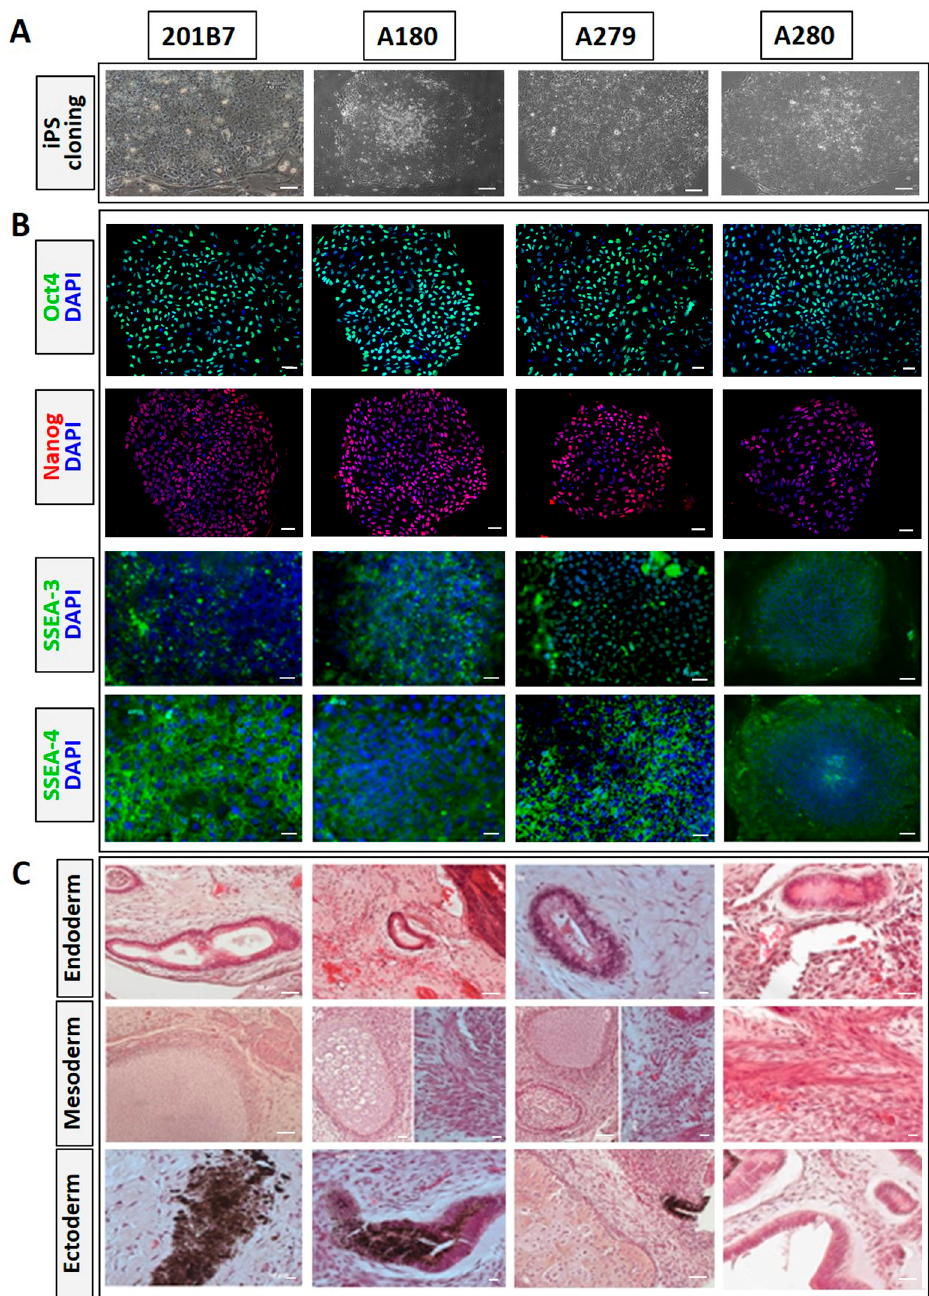
Figure 1. Pluripotency characterization of induced pluripotent stem cells (iPSCs) derived from patients with musculocontractural Ehlers–Danlos syndrome caused by mutations in the carbohydrate sulfotransferase 14 gene (mcEDS- CHST14 ). ( A ) Wild-type (WT) iPSCs (201B7) and iPSCs from three mcEDS- CHST14 patients (A2:A180, A3:A279, A4:A280) exhibiting tight packing in colonies and a high nucleus-to-cytoplasm ratio. Scale bars, 70 µm. ( B ) Positive staining of all iPSCs for pluripotency markers Oct4, Nanog, SSEA-3, and SSEA-4. Scale bars, 100 µm. ( C ) All iPSC lines were implanted into NOD mice. All three germ-layer structures were found in iPSC-derived teratomas, including gut-tube-like structures (endoderm), smooth muscle or cartilage (mesoderm), and pigmented cells or neural tube (ectoderm). Scale bars, 50 µm.